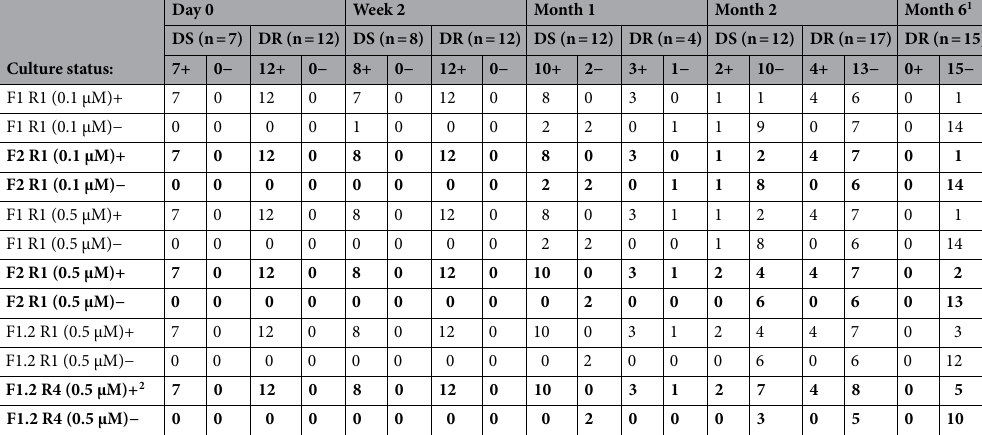
culture positive sputa. We next ascertained whether the five 16S rRNA primer sets were able to detect 16S rRNA in patient sputa that were culture negative (defined as negative by all culture methods). Over all timepoints, the positivity rates for the five 16S rRNA primer sets were 8–33% for the DS cohort and 24–38% for the DR cohort in culture negative sputa (Table 5, Table S19). At month two specifically, the positivity rates for the five primer sets were 10–40% for the DS cohort and 46–54% for the DR cohort; and at month six it was 7–20% for the DR cohort (who adhere to a 20 month treatment regimen). Of note, in these experiments 16S rRNA amplification was absent when reverse transcriptase was left out of the qRTPCR reaction, confirming RNA specific amplification (Fig. 5).